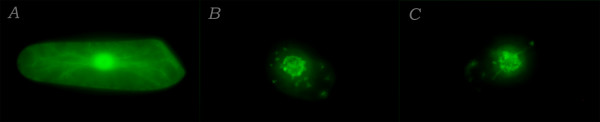
Transient expression of GFP and GFP fusion proteins in BY-2 tobacco cells. (A) GFP protein [35SΩ-sGFP (S65T)]; (B) Arabidopsis chloroplast targeting signal (pt)-GFP fusion protein [35SΩ-pt-sGFP (S65T)]; (C) putative localization signal of GGPP synthase-GFP fusion protein [35SΩ-GGPP synthase-sGFP (S65T)]